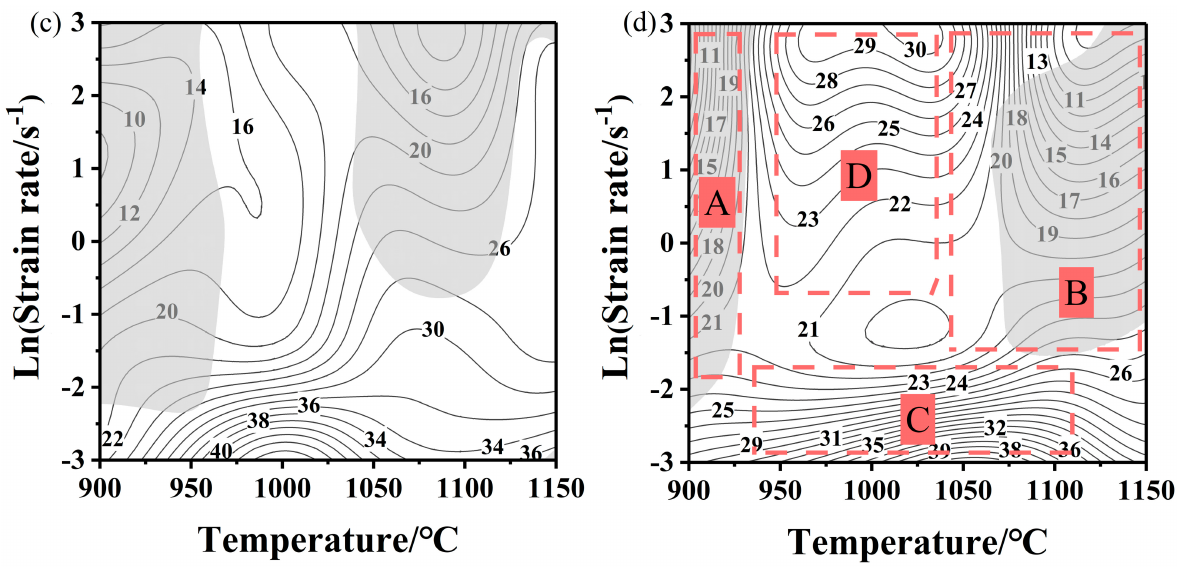
Figure 10. Processing maps under strains of ( a ) 0.1 s − 1 , ( b ) 0.3 s − 1 , ( c ) 0.5 s − 1 , and ( d ) 0.7 s − 1 .